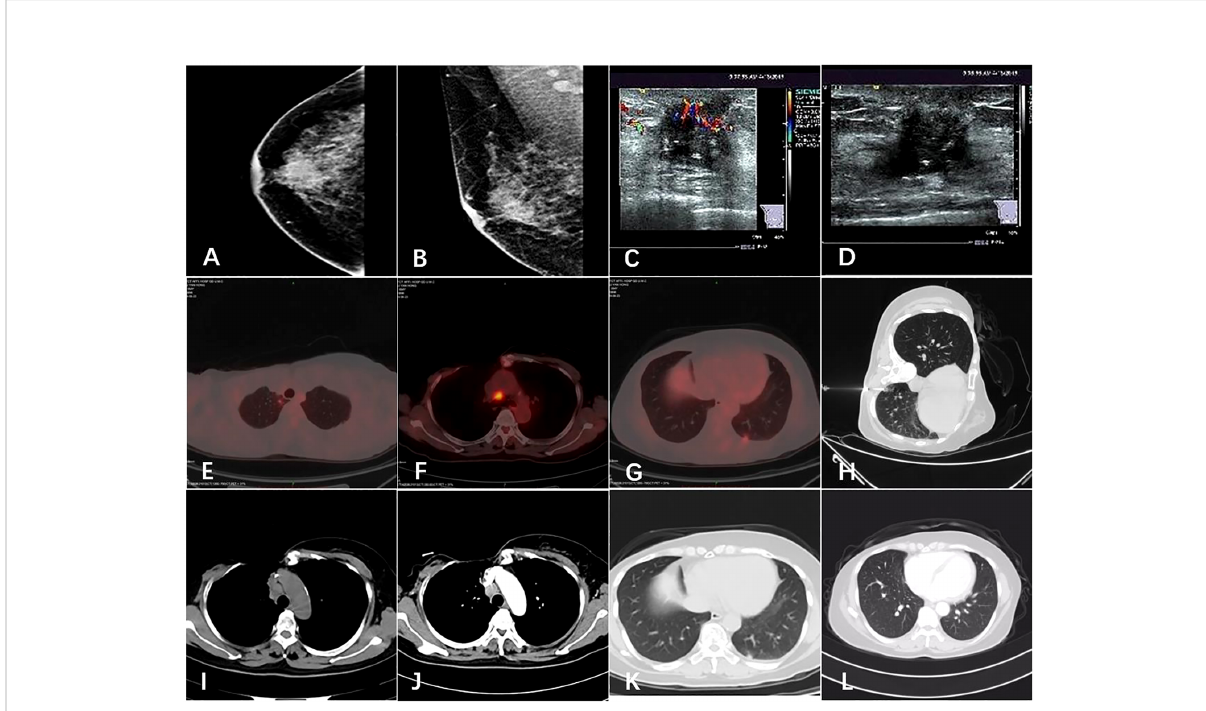
FIGURE 1 Imaging of the tumor. (A, B) Mammogram showed an irregular high-density shadow posterior to the nipple of the right breast and bilateral axillary lymph nodes were slightly enlarged. (C, D) Ultrasound showed a hypoechoic nodule on the right breast, 0.3 cm from the nipple at 12 o ‘ clock, 1.7 × 1.4 cm in size. (E, F, G) The patient ’ s PET-CT results in 2019. Hypermetabolic lesions were found in the subpleura of the apical segment of the right upper lobe of the lung, the mediastinal anterior tracheal posterior vena cava lymph nodes and the subpleura of the basal segment of the left lower lobe. (H) Chest computed tomography guided needle biopsy of the left pulmonary nodule was performed. (I, J, K, L) Comparison of pulmonary nodules and mediastinal metastatic lymph nodes before and after the